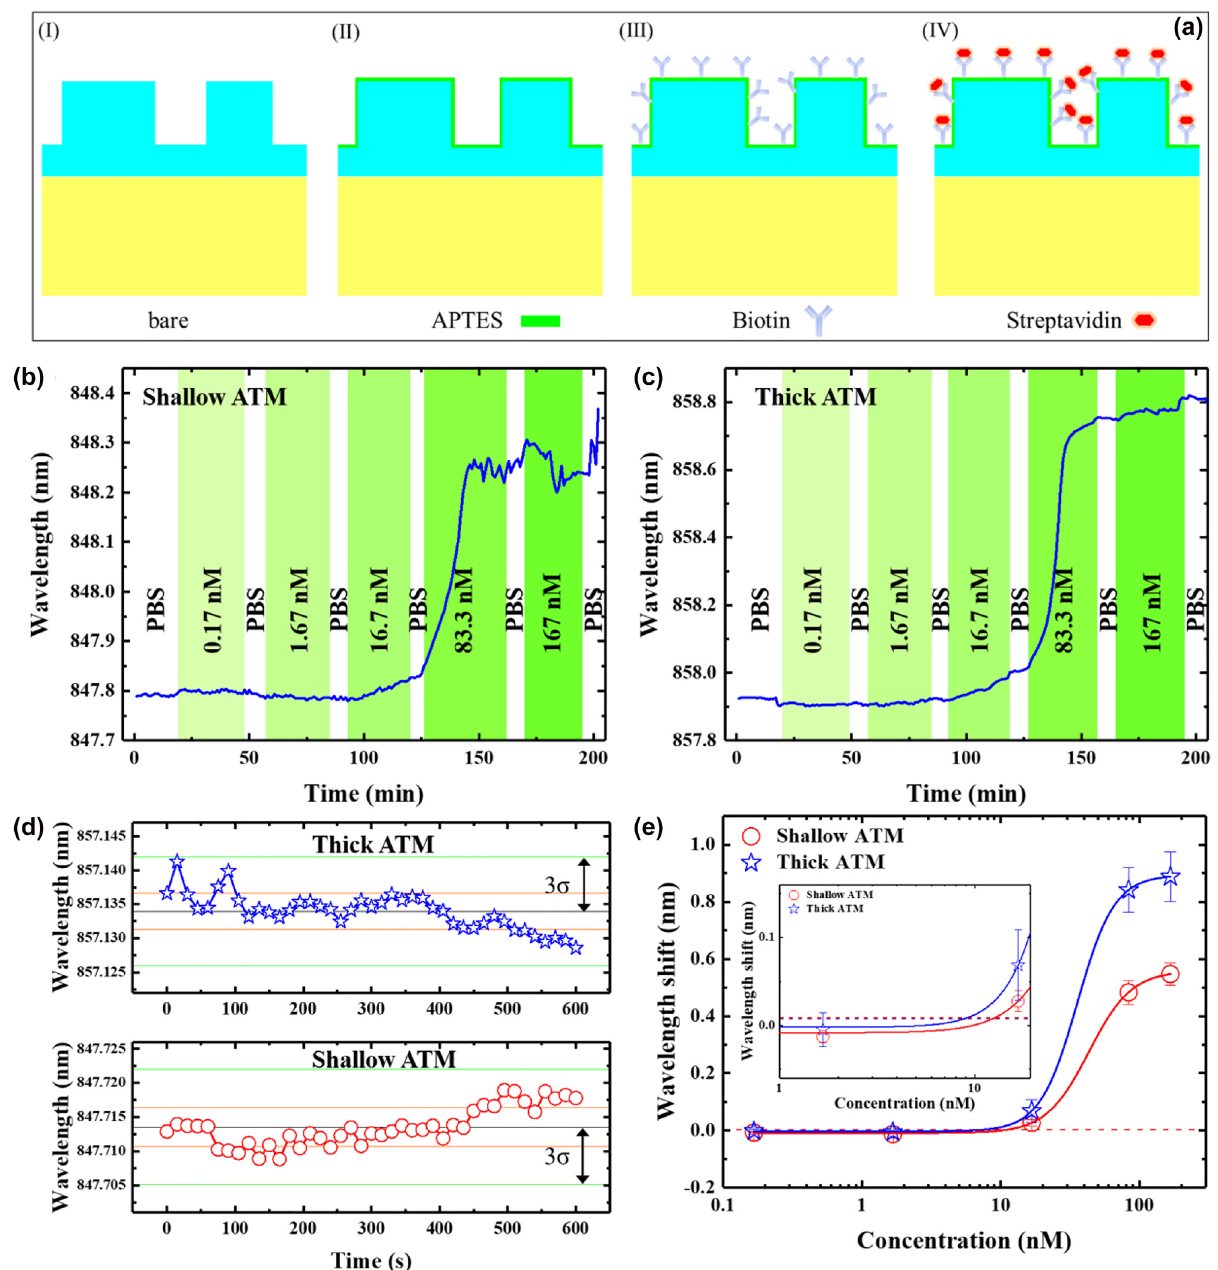
Figure 8: Specific binding of streptavidin to the ATM structures. (a) Schematic of the surface functionalization process. Real-time biomolecular interaction response of TM (1,1) mode for (b) shallow ATM and (c) thick ATM structure. (d) Resonant wavelength versus time in PBS buffer. The orange and green lines indicate one and three standard deviations ( 𝜎 ) away from the mean, respectively. (e) Streptavidin calibration curves for shallow ATM (red) and thick ATM (blue). The red and blue horizontal dashed lines mark the detection limit for shallow ATM and thick ATM,